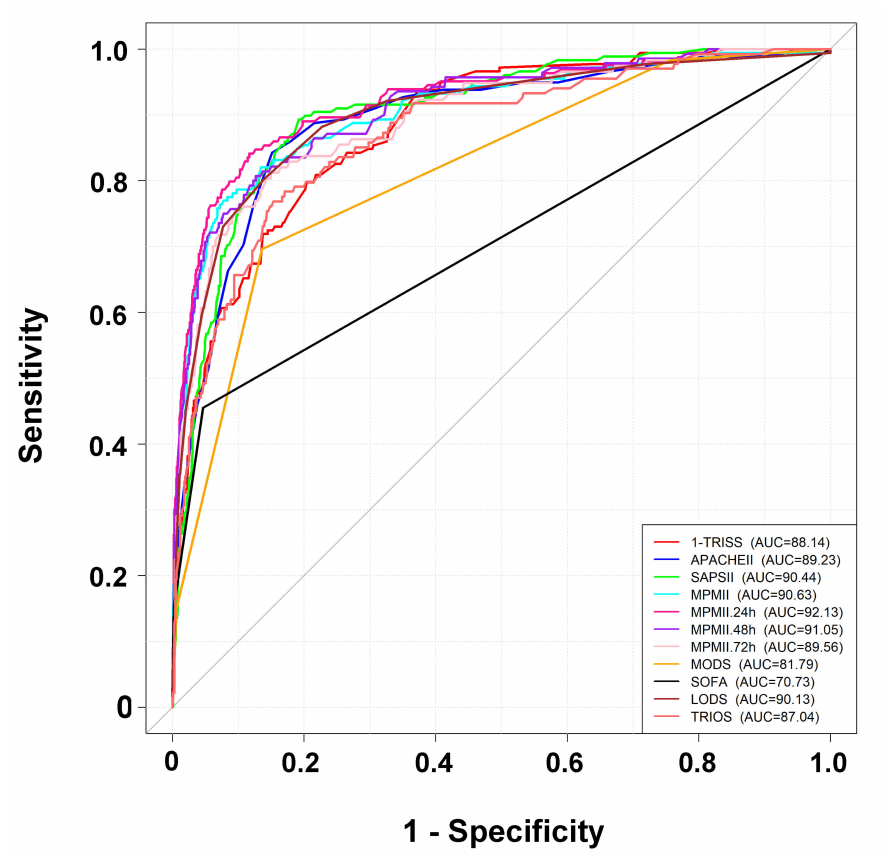
Figure 2. The receiver operating characteristic curves and the area under the curve (AUC) of the prognostic scoring systems for trauma patients with critical illness. Table 4. Comparison of the predictive performance of the evaluated prognostic scoring systems for trauma patients with critical